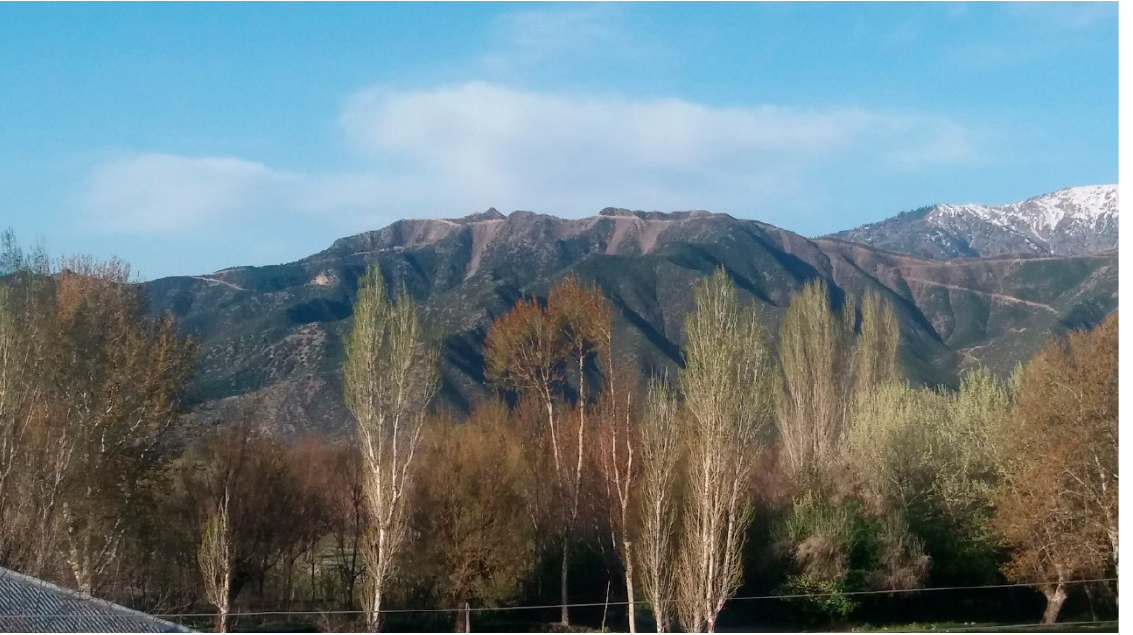
Figure 9. Road construction on top of Mundaire Mountain for border protection. Source: Photo © Kamal Hussain, 12 April 2020).